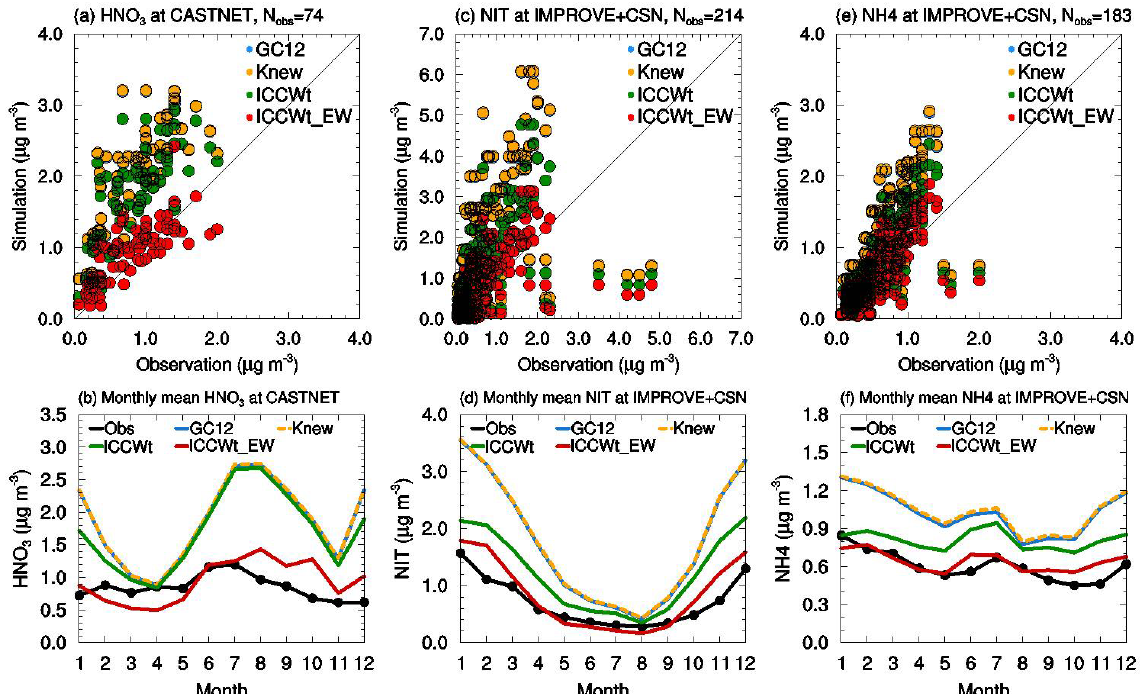
Figure 2. (a) Scatter plot of observed and simulated annual mean HNO 3 at CASTNET sites and (b) variations of monthly mean for the year 2011 showing the comparison between nitric acid mass concentrations observed at CASTNET sites (black) and simulated by the GC12 (blue), Knew (yellow dash), ICCW t (green), and ICCW t _EW (red) cases. Panels (c) and (d) are the same as panels (a) and (b) but for nitrate at IMPROVE + CSN sites. Panels (e) and (f) are the same as panels (a) and (b) but for ammonium at IMPROVE + CSN sites. It is worth noting that the differences between G12 (blue) and Knew (yellow dash) are small. Table 1. Observed annual mean surface concentrations of HNO 3 , nitrate, and ammonium at CASTNET, IMPROVE, and CSN sites. Annual mean surface concentrations (Mean), normalized mean bias (NMB), and correlation coefficient ( r ) between observed and simulated annual mean values for the three species for the GC12, Knew, ICCW t , and ICCW t _EW cases. HNO 3 NIT NH 4 Mean NMB r Mean